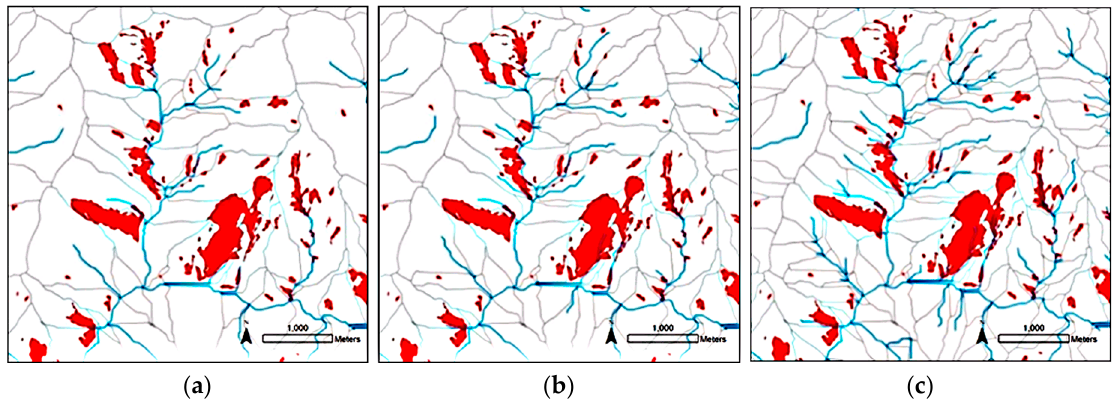
Figure 3. Illustration of the landslide polygons overlaid on the river system calculated from the value of accumulated flow: ( a ) 900, ( b ) 600, ( c ) 300.